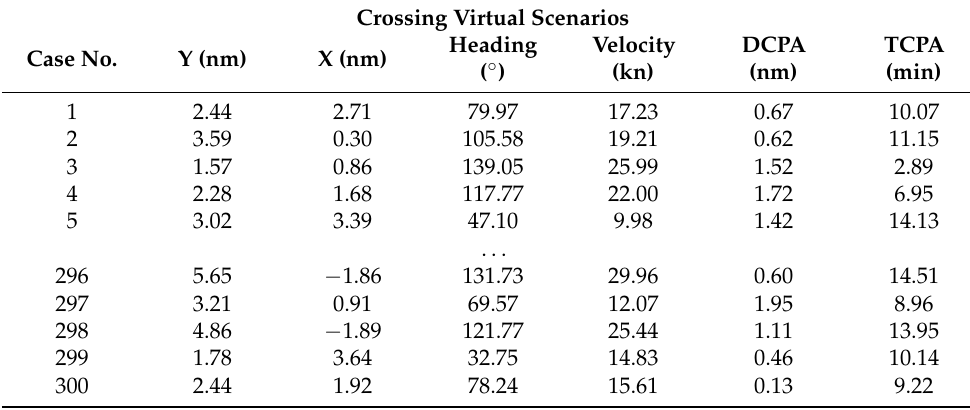
Table 5. The virtual scenarios generated for crossing